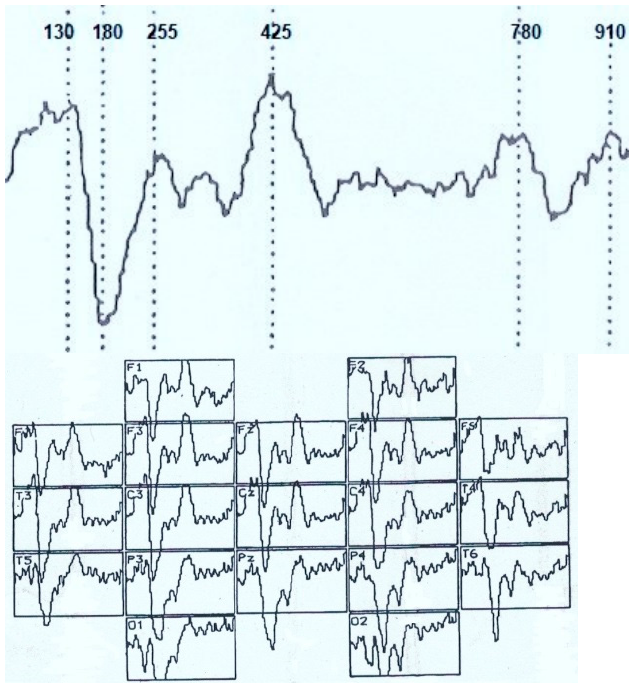
Figure 2. Visual evoked potential (numbers–time, ms) and distribution of VEP according to the 10–20 system during the perception of an unrecognizable (oddball) visual image. Analysis time—1000 ms.